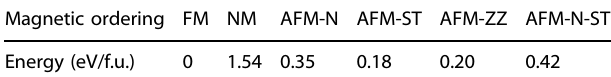
Table 1. The DFT calculated energies (eV/f.u.) for different (out-of- plane) magnetic con fi gurations with respect to the lowest FM energy state which is set to